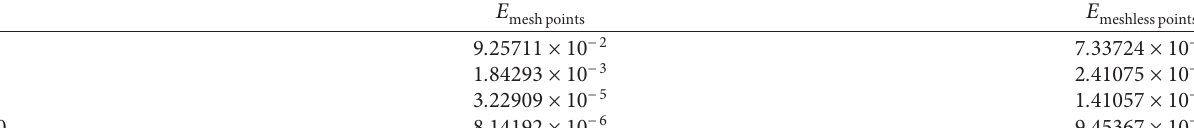
Table 2: Accuracy of RBF to Fredholm linear two-dimensional integral equation for mesh and meshless points.